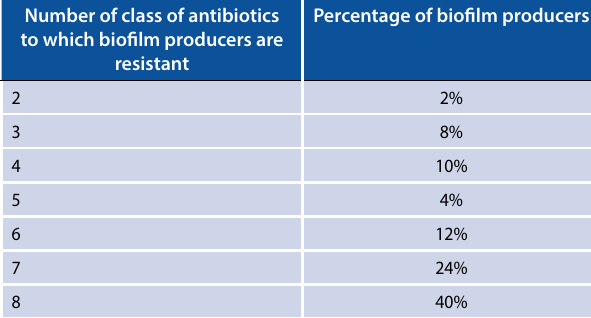
Table 6: Multiple drug resistance pattern of biofilm producers Number of class of antibiotics to which biofilm producers are